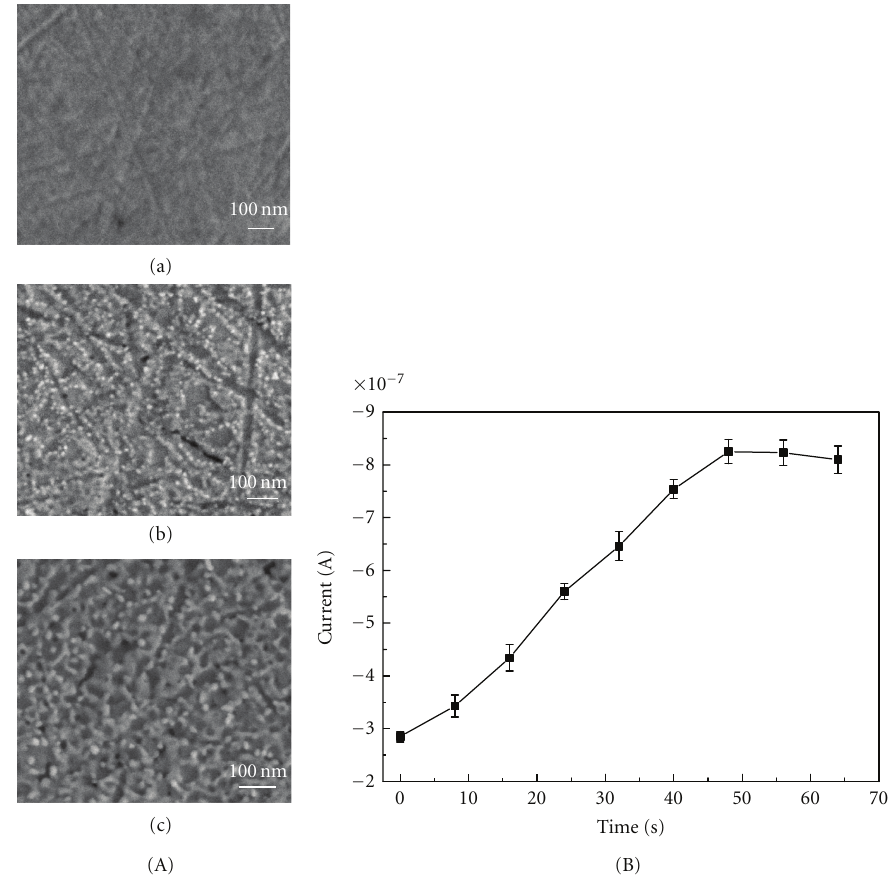
Figure 2: (A) SEM images of AuNPs at various deposition time. (a) 0, (b) 50 s, (c) 110s, Deposition potential is − 250 mV (versus SCE). (B) DPV responses of adriamycin dependence of deposition time. Electrochemical deposition wasperformed in 3.0mM HAuCl 4 at various times ( t = 0,8,16,24,32,40,48,56, and 64s). DPV measurement was performed in 0.01M PBS (pH 7.40) containing 1.0 × 10 − 6 M adriamycin. DPV parameters were as follows: potential range: − 0.45 ∼− 0.80 V; amplitude: 0.05 V; pulse width: 0.05s; sample width: 0.0167s; pulse period: 0.2s; quiet time: 2